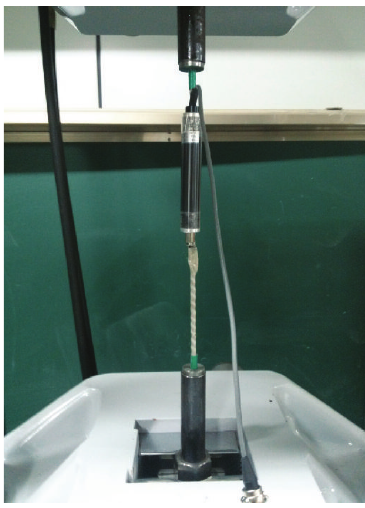
Figure 5: Tensile test setup.